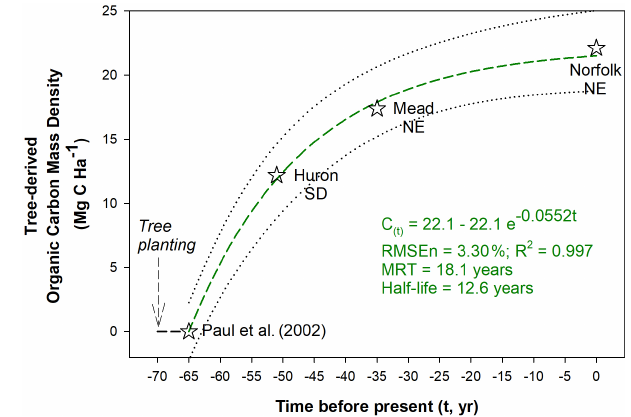
Figure 6. Reconstruction of soil organic carbon storage within the 0 to 15cm depth increment following land use conversion from an- nual cropland to afforestation in the United States. The arrow indi- cates the time of tree planting ( − 70 years). Based on a literature re- view by Paul et al. (2002), we included a lag phase of 5 years follow- ing tree planting. Huron and Norfolk data were derived from results presented in Fig. 4. Mead data were recalculated from Hernandez- Ramirez et al. (2011) as compiled in Table 3. This assemblage sup- ports that afforested soils were approaching steady state at nearly 70 years after tree planting, as required for first-order kinetic mod- eling. The first-order kinetic model (Eq. 1) is depicted by the solid curvilinear fitting, where k is the first-order kinetic rate constant equivalent to accretion rate under afforestation, and MRT stands for mean residence time. Normalized root-mean-square error (RMSEn) and coefficient of determination ( R 2 ) for the k model are also pro- vided. The 95% prediction bands of this k model are provided as dotted lines. This nonlinear trajectory describes and highlights the contribution of trees to soil C accrual.